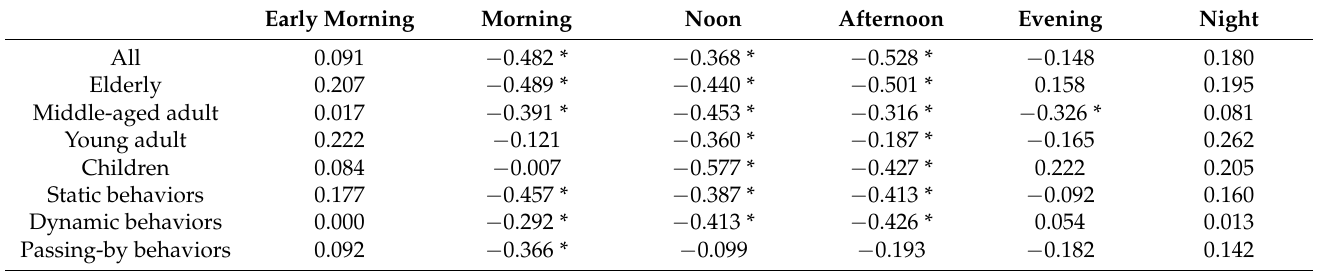
Table 5. Correlation analysis of parks using behavioral characteristics and temperature over different time